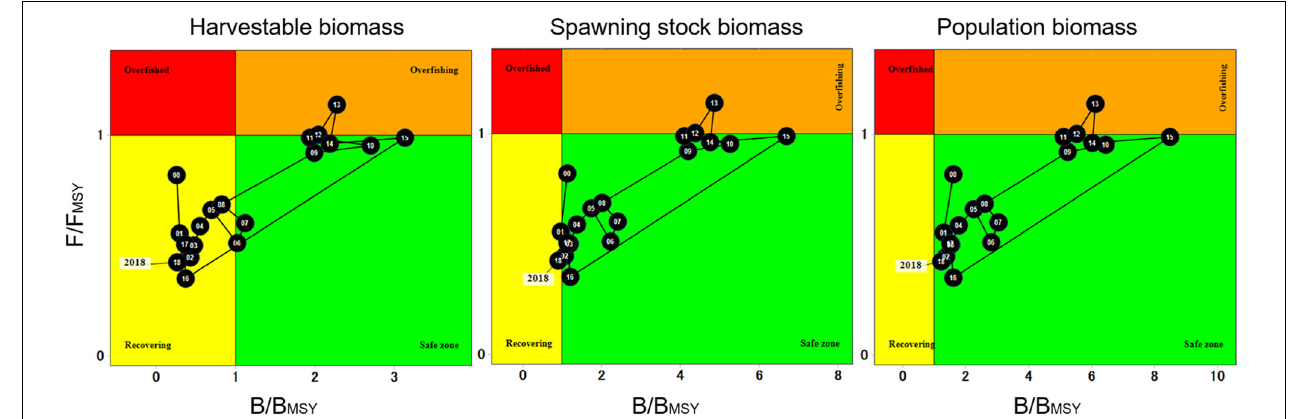
FIGURE 9 | Kobe plots representing 19-year trend of overall harvestable, spawning stock and population biomass of red sea urchin.